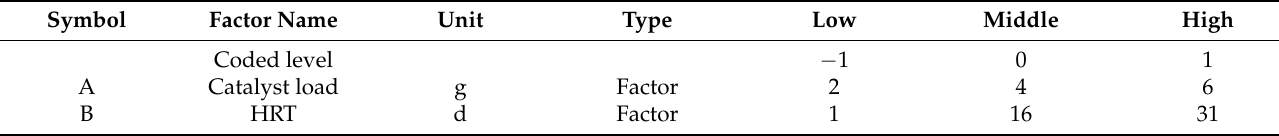
Table 2. Box- Benhken design matrix.